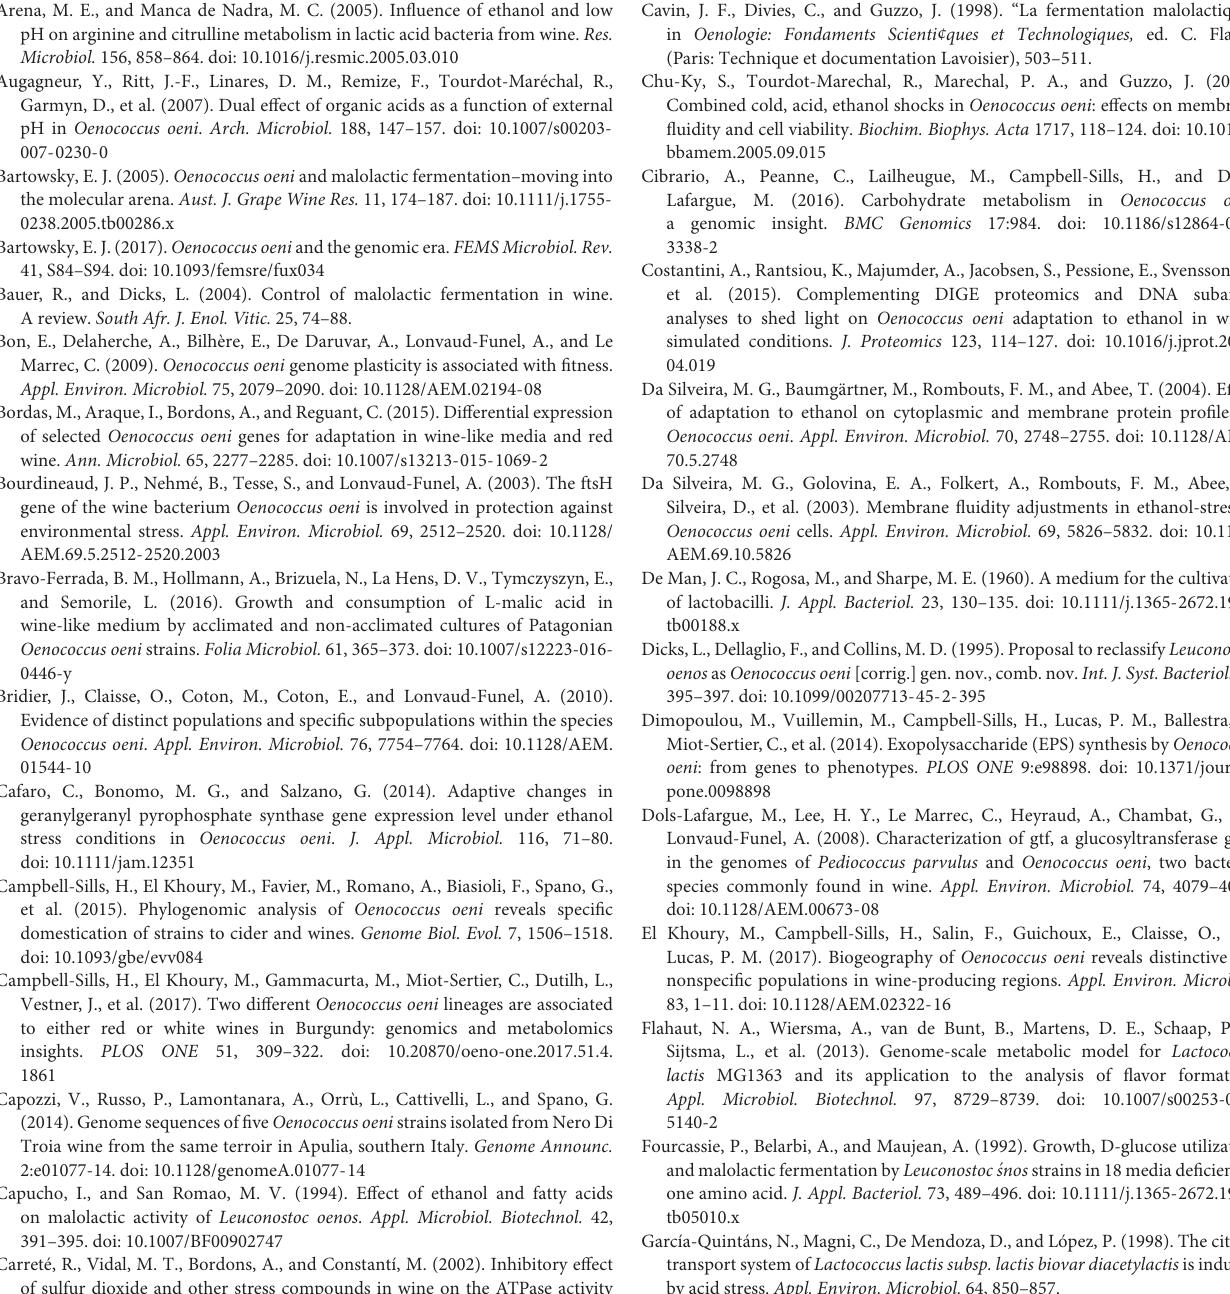
(I) Isoleucine and (J) Phenylalanine. Statistical analysis only was performed in phase I and shared letters indicate no significant difference (Mood test, p < 0.05). FIGURE S4 | Metabolic flux redistribution of the central carbon metabolic pathways of O. oeni PSU-1 upon cultivation in a culture medium without and with 3, 6, 9, and 12% (green boxes, from top to bottom) ethanol concentration, during growth phase II. FIGURE S5 | Metabolic flux redistribution of the central carbon metabolic pathways of O. oeni PSU-1 upon cultivation in a culture medium without and with